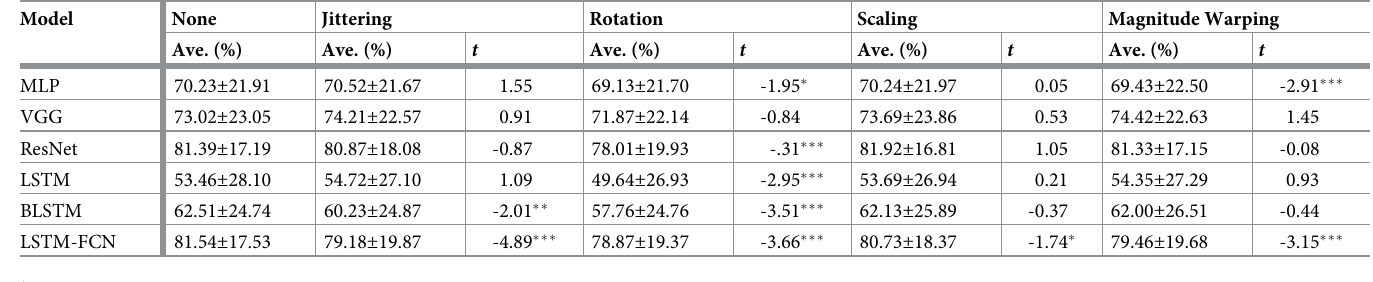
Table 1. Comparative results for magnitude domain transformation-based data augmentation methods. Model